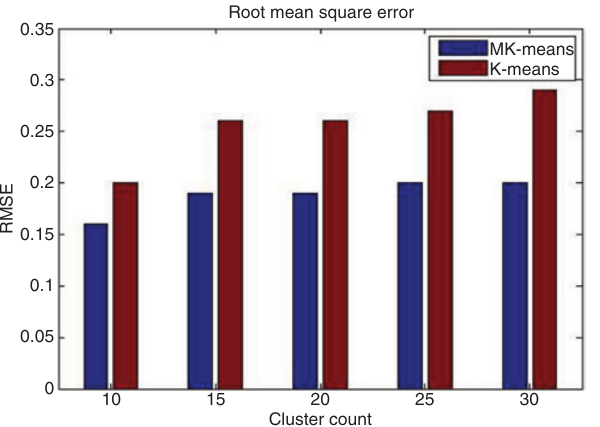
Figure 6: Performance Comparison of RMSE Plots by Varying Cluster Counts.